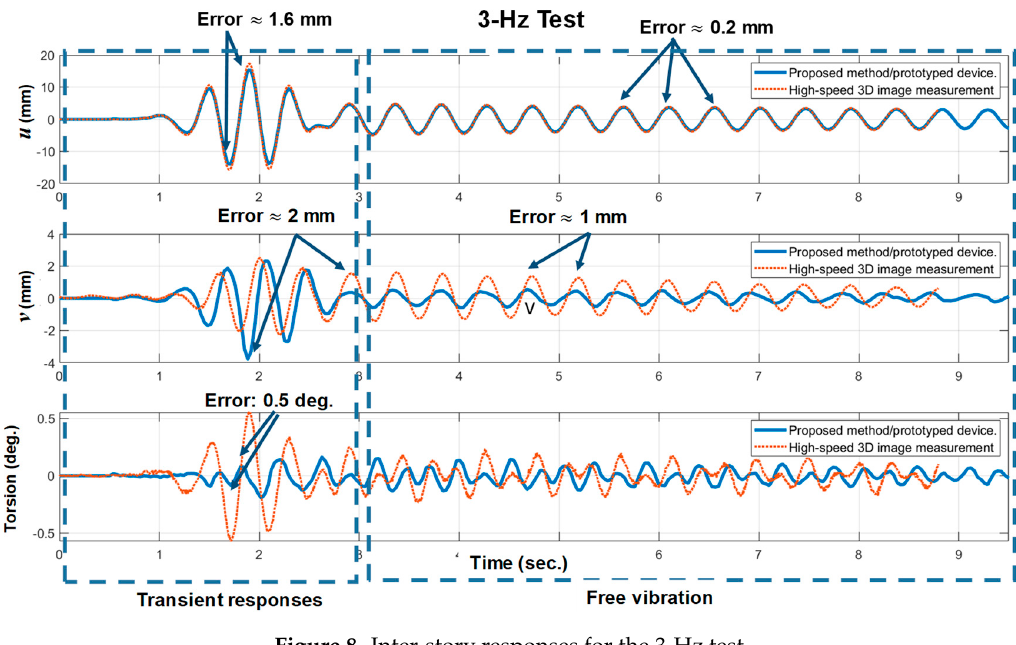
Figure 8. Inter-story responses for the 3-Hz test.